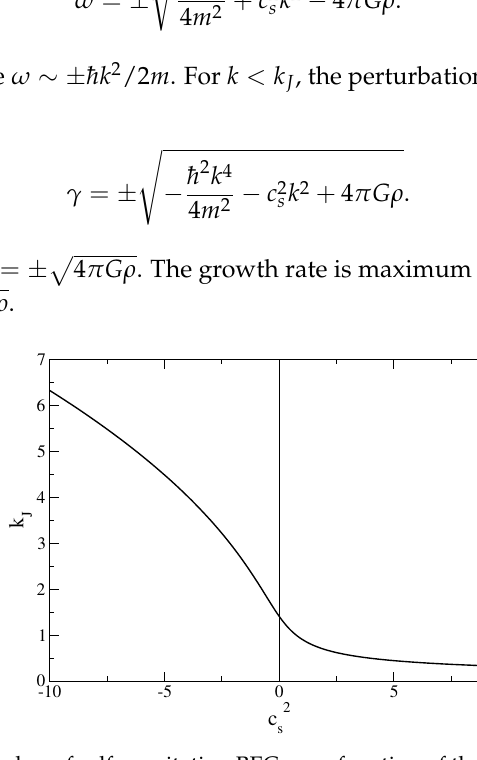
Figure 6. Jeans wavenumber of self-gravitating BECs as a function of the the squared speed of sound. We have normalized the Jeans wavenumber by ( 4 π G ρ m 2 /¯ h 2 ) 1/4 and the squared speed of sound by ( 4 π G ρ ¯ h 2 / m 2 ) 1/2 . This is equivalent to taking 4 π G = ρ = m = ¯ h = 1 in the dimensional equations. For c s = 0, we have k J = ( 16 π G ρ m 2 /¯ h 2 ) 1/4 . For c 2 s → + ∞ , we have k J ∼ ( 4 π G ρ / c 2 s ) 1/2 . For c 2 s → − ∞ , we have k J ∼ ( 4 m 2 | c 2 s | /¯ h 2 ) 1/2